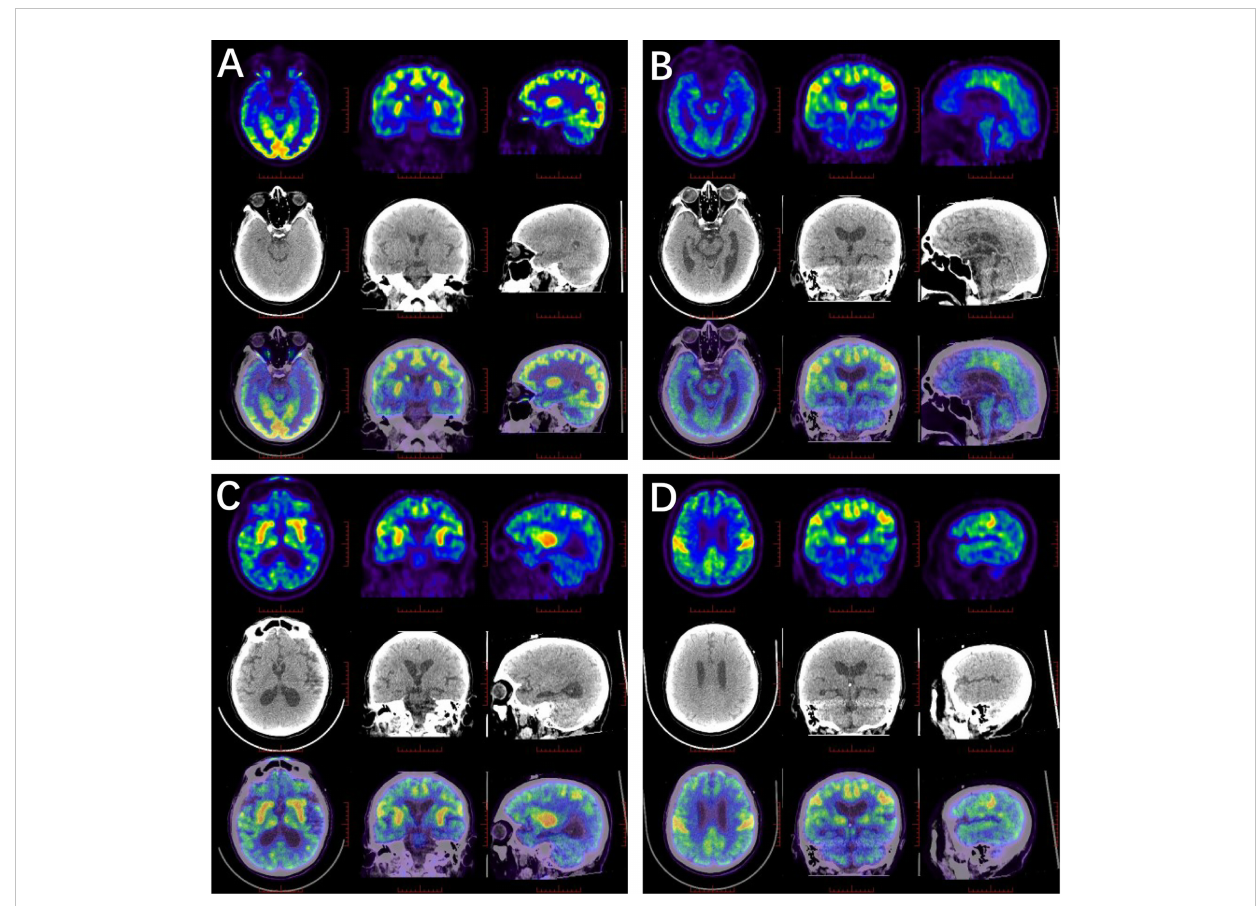
FIGURE 2 18 F-FDG PET/CT scan in anti-amphiphysin encephalitis. (A) Glucose metabolism decreased in the right hippocampus (Patient #1). (B – D) High FDG uptake in the bilateral central cortex, left fronto-parietal para-sagittal, bilateral caudate heads, putamen and right thalamus, while the remaining brain cortex was diffusely and slightly decreased (Patient